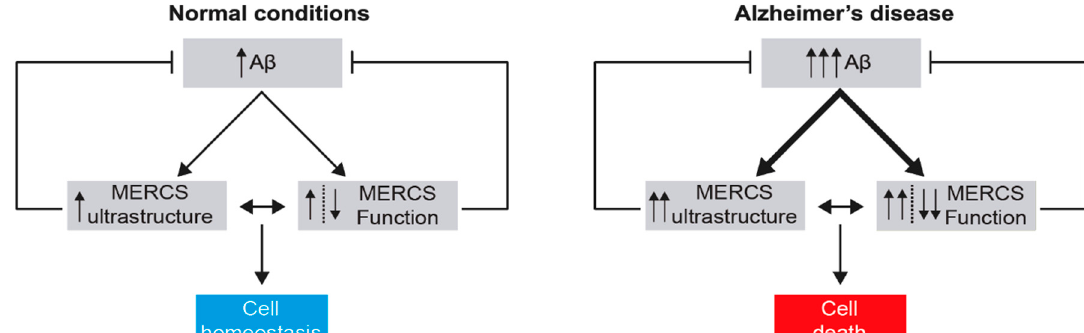
Figure 4. Effect of A β in MERCS under normal and AD conditions. Schematic representation of what happens in the cell upon an increase in A β levels in normal and AD conditions. Under normal conditions, an increase in A β leads to an increase in the connectivity between the ER and mitochondria, affecting MERCS ultrastructure and function. Together, the increased connectivity and altered function of MERCS prevent further A β formation. However, when the levels of A β are too high, this negative feedback loop is not enough to decrease the levels of this peptide. A β continues to induce an increase in the connectivity between the ER and mitochondria, which culminates in Ca 2+ overflow into mitochondria, activating cell death. Arrows point up correspond to up-regulated and arrows point down down-regulation. Two arrows side-by-side correspond to a further increase or decrease biological process as compare to normal conditions.